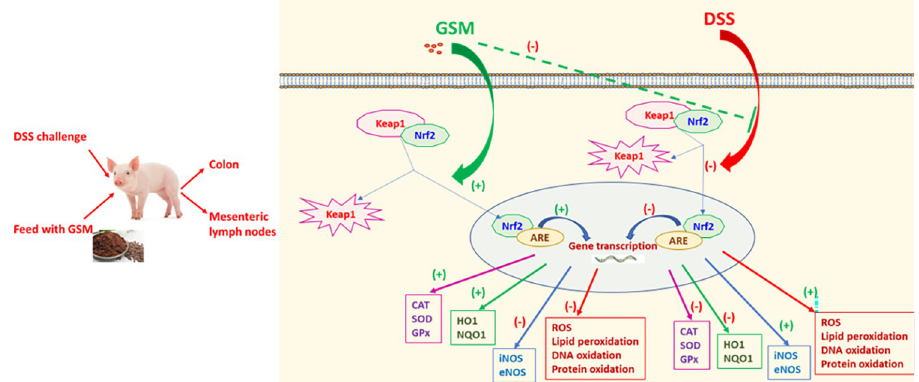
Fig 9. The postulated mechanism of action of DSS and GSM on oxidative stress markers and signalling. DSS treatment reduced the nuclear translocation of nNrf2 into the nucleus leading to (i) stimulation of ROS production and the oxidative degradation of DNA, proteins and lipids; (ii) reduction of the gene expression and activity of antioxidant enzymes, CAT, SOD, GPx and increase of eNOS and iNOS expression. GSM showed anti-oxidant properties counteracting the pro-oxidant response induced by DSS and restoring the levels of endogenous antioxidant enzymes in colon and mesenteric lymph nodes. These effects were mediated via Nrf2 signalling pathway by restoring the expression of Nrf2 , Keap1 , HO1 and NQO1